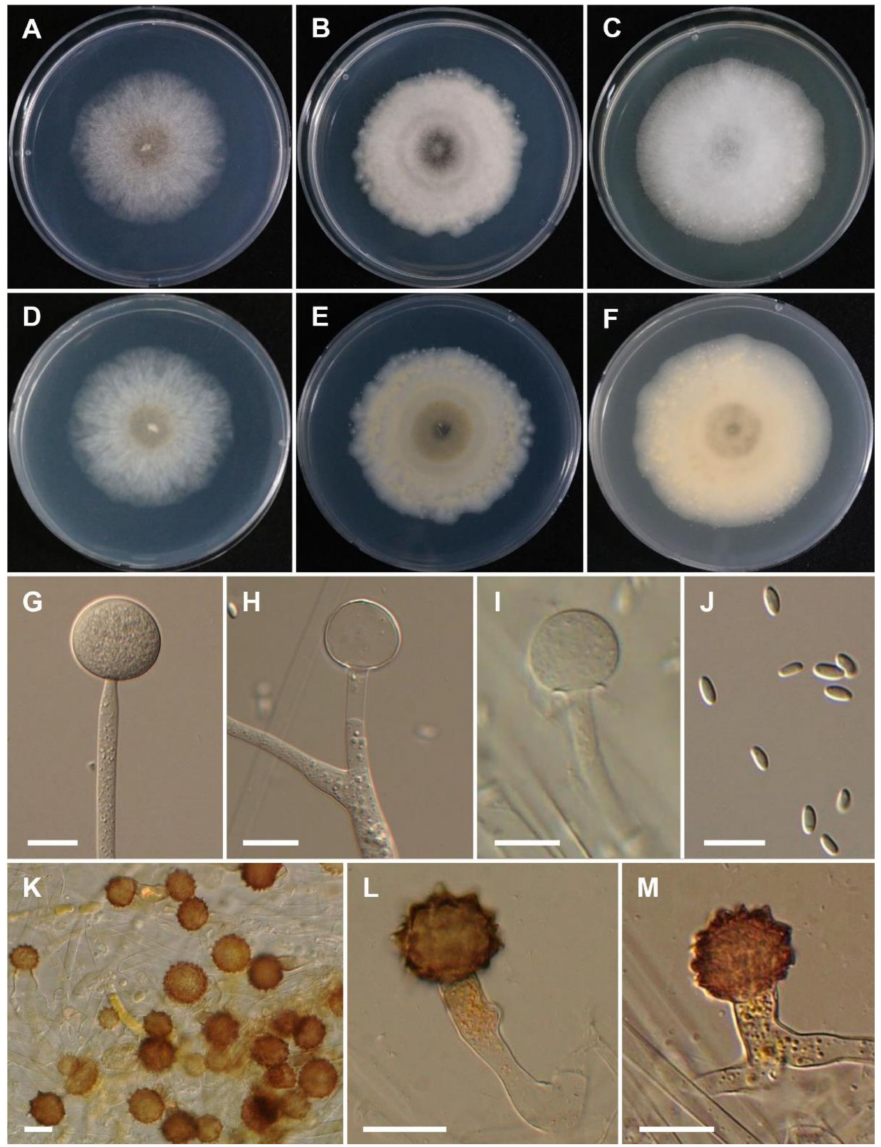
Figure 4. Morphology of Mucor hyangburmii . ( A , D ) Colony on synthetic agar mucor (SMA). ( B , E ) Colony on potato dextrose agar (PDA). ( C , F ) Colony on malt extract agar (MEA). ( G ) Young sporangium. ( H ) Sterile sporangium. ( I ) Columella. ( J ) Sporangiospores. ( K – M ) Azygospores on MEA. Scale bars = 20 µ